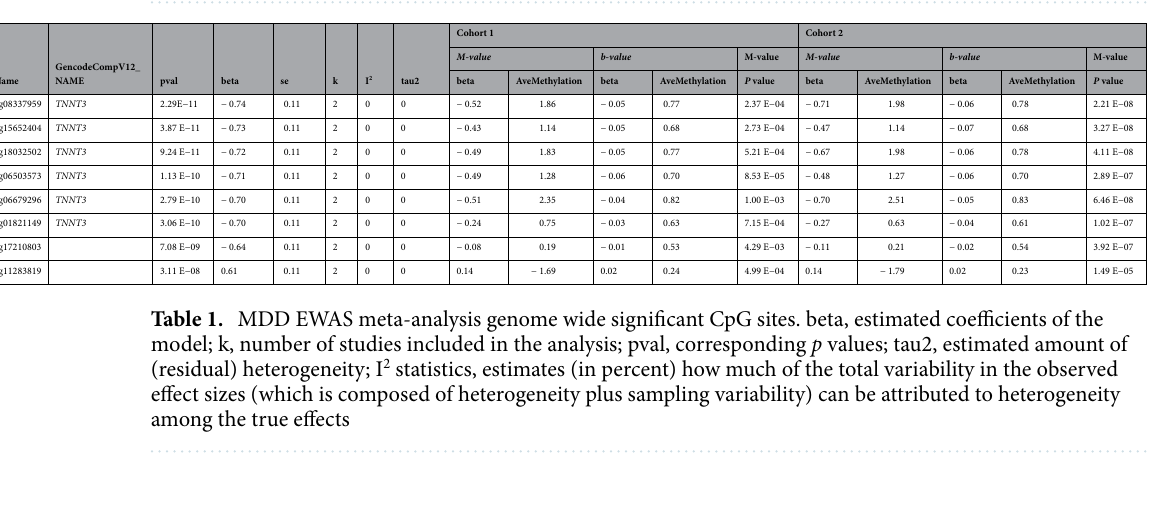
Figure 1. Manhattan plot of DMP analysis of MDD case–control EWAS meta-analysis.